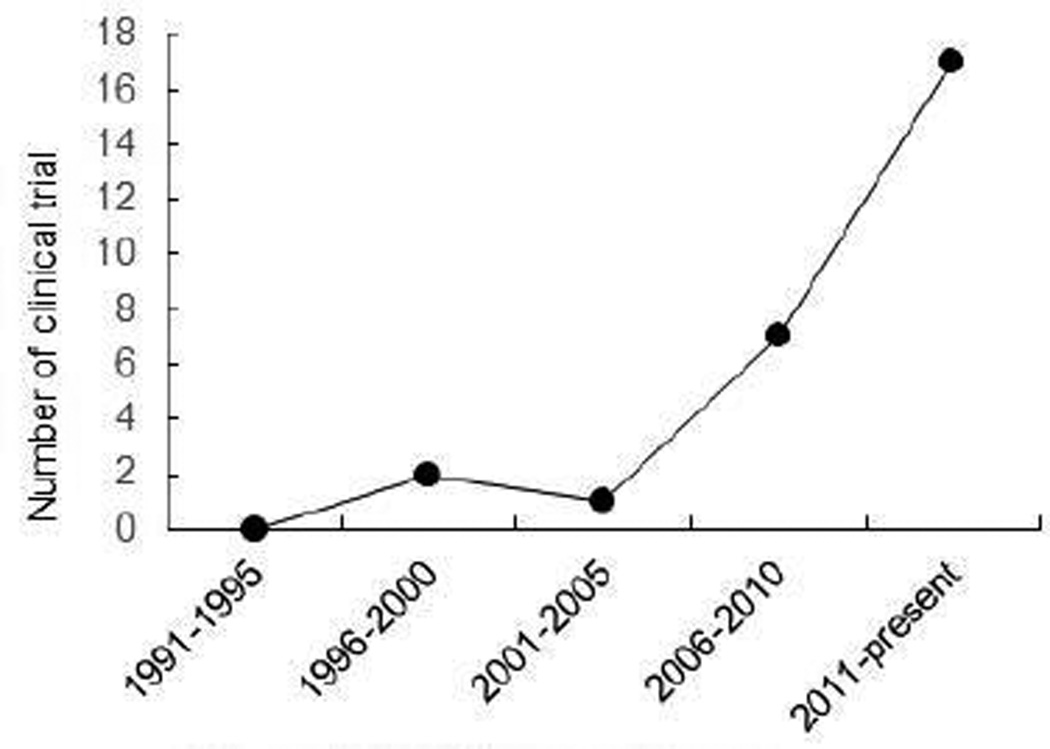
HCC immunotherapy.